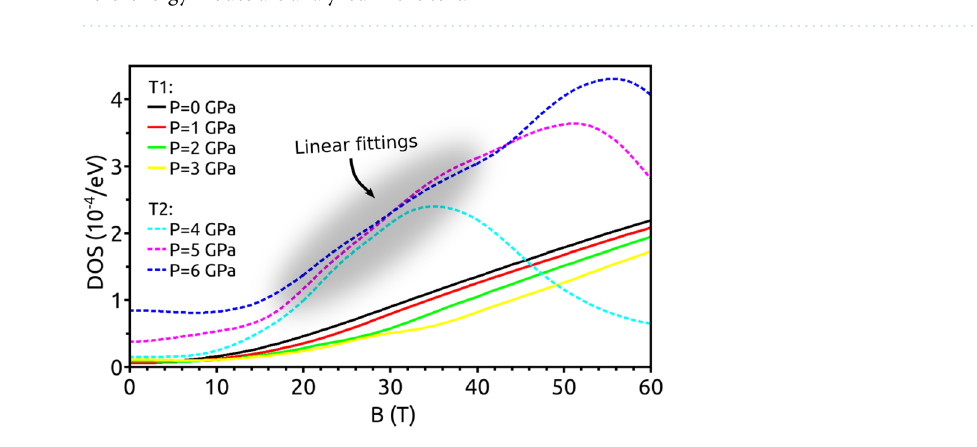
Figure 8. Colormap of the density of states as a function of an applied magnetic field B along the z-direction ( a , b ) and perpendicular to it ( c , d ) for the T1 phase ( a , c ) and for the T2 phase ( b , d ). Magnetic oscillations and zero-energy modes are analyzed in the text.